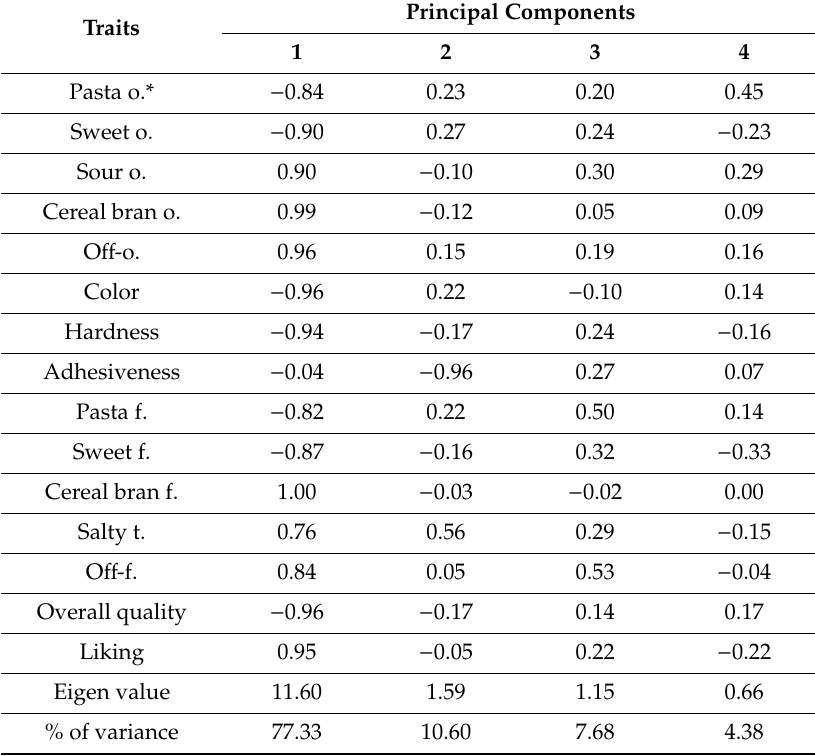
Table 5. The factor loadings of individual main components separated from MFA (multiple factor analysis) for attributes obtained in QDP method (Quantitative Descriptive